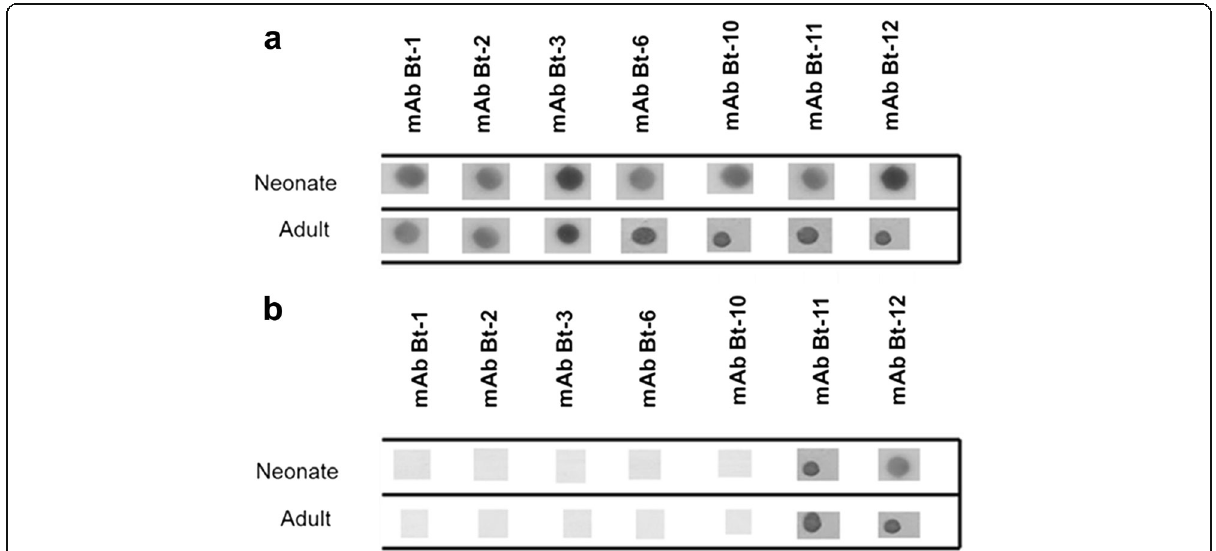
Fig. 3 Analysis of mAbs against neonates and adult individual venoms. In ( a ) individual venom of B. jararacussu and ( b ) individual venom of southeastern B. jararaca . One microgram of each venom was applied to a nitrocellulose membrane and incubated with mAbs, followed by anti-mouse IgG-peroxidase. The antigen-antibody reaction was developed. Given the reproducibility of the mAbs against ten individual venoms (neonates and adults) of B. jararacussu and B. jararaca , in this study we show representative results using the venom of one neonate and one adult of each